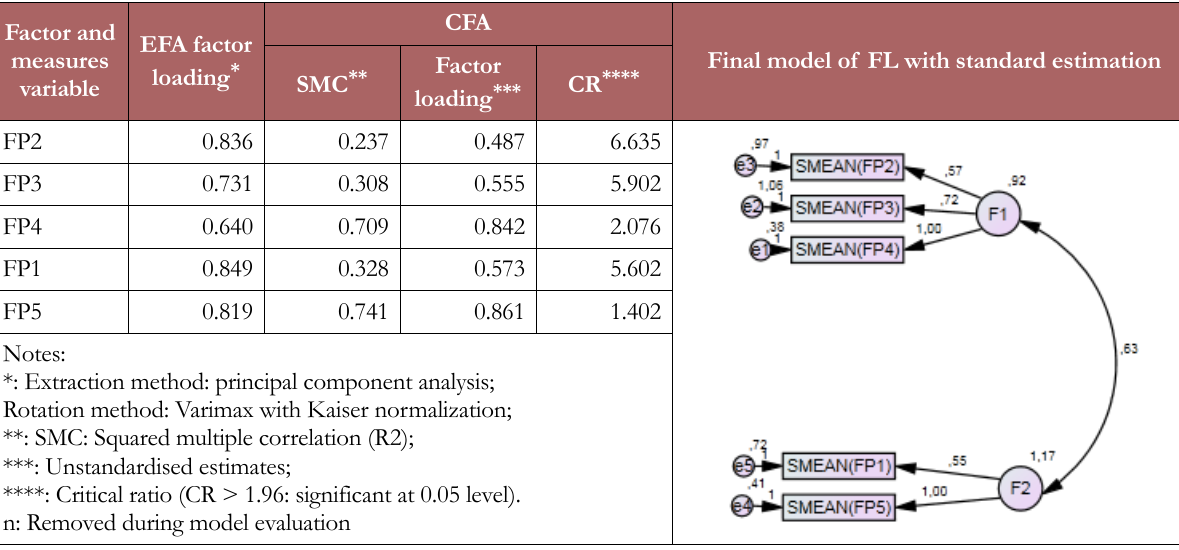
Table 16. EFA and CFA of the FP